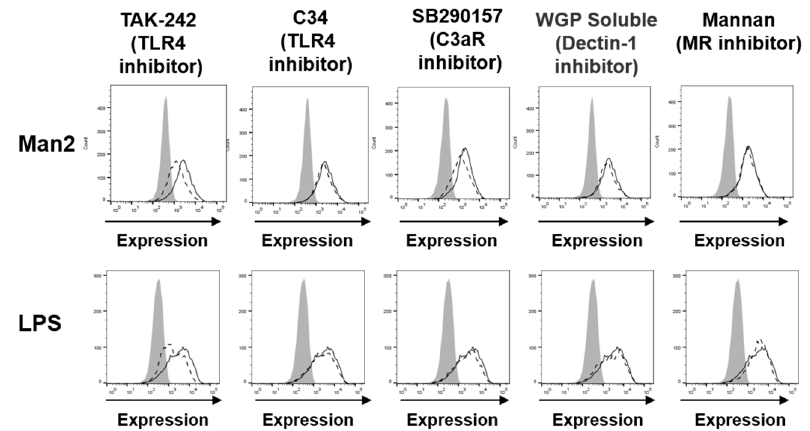
Figure 4. Effect of receptor inhibitors on activation of Man2-treated BMDCs. BMDCs derived from C57BL/6 mice (1 × 10 6 cells/mL) were treated with either 100 nM TAK-242, 50 μ M C34, 100 μ M SB290157, 100 μ g/mL of WGP ® Soluble, or 200 μ g/mL of mannan for 30 min, and subsequently stimulated with 50 μ M Man2 or 5.0 ng/mL of LPS for 24 h. Expression levels of CD40 on the surface of cells were measured by FACS. Grey lines: unstimulated and unstained cells, dashed lines: inhibitor- and Man2-treated and mAb-stained cells, and black lines: inhibitor-untreated, Man2-treated and mAb-stained cells. The data are representative for two independent experiments.